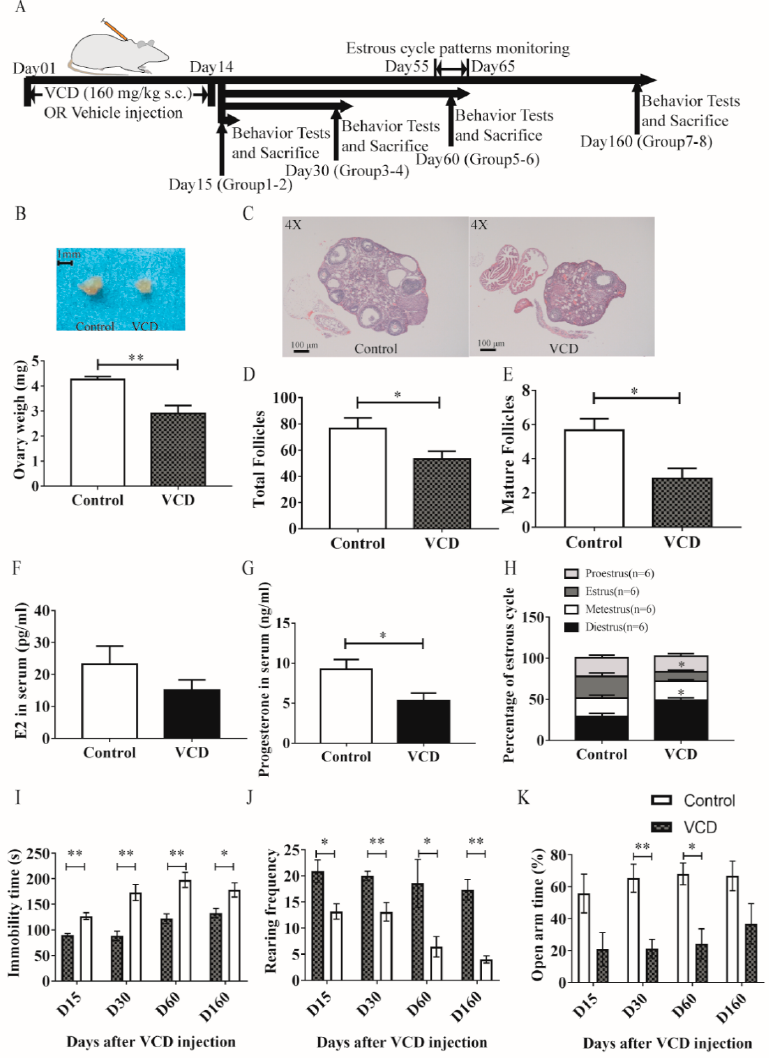
Figure 1. VCD exposure induces ovarian damage, depression- and anxiety-like behaviors in female mice. ( A ) Schematic of the protocol for VCD exposure, estrous cycle patterns monitoring and be- havioral testing. ( B ) Gross morphology (upper panel) and weight (low panel) of mice ovaries. ( C ) HE staining of ovaries at 4× for control and VCD-treated mice. ( D , E ) Total ovarian follicle numbers ( D ) and mature ovarian follicle numbers ( E ) in the ovaries of control and VCD-treated mice. ( F , G ). Serum concentrations of estradiol (pg/mL) ( F ) and progesterone (ng/mL) ( G ) in control and VCD- treated mice. ( H ) Percentage of each phase of the estrous cycle in control and VCD-treated mice. Pearson’s chi-square test were used for comparison each phase between the two groups. ( I ). Immo- bility time in FST. ( J ) Rearing frequency in OFT. ( K ) Percentage of time spent in the open arms in EPM. Statistical significance in ( B – G ) was determined using Mann–Whitney test or Students’ t -test. Statistical significance in ( I – K ) was determined using two-way ANOVA analysis with Sidak’s mul- tiple comparison test or Mann–Whitney test. Data are represented as mean ± SEM, n = 6 per group; * p < 0.05, ** p < 0.01.